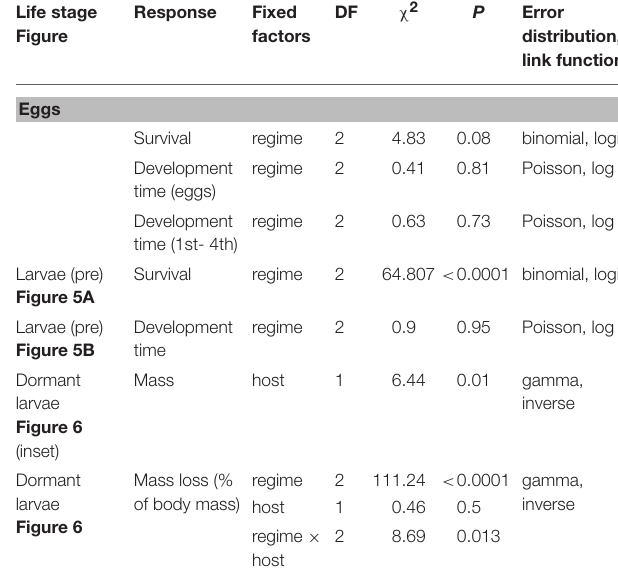
TABLE 1 | GLMM summaries for effects of heatwave exposure during summer on survival, development time and mass of E. phaeton at different ontogenetic stages: eggs, pre-overwintering (pre), and dormant larvae. All models included clutch as a random